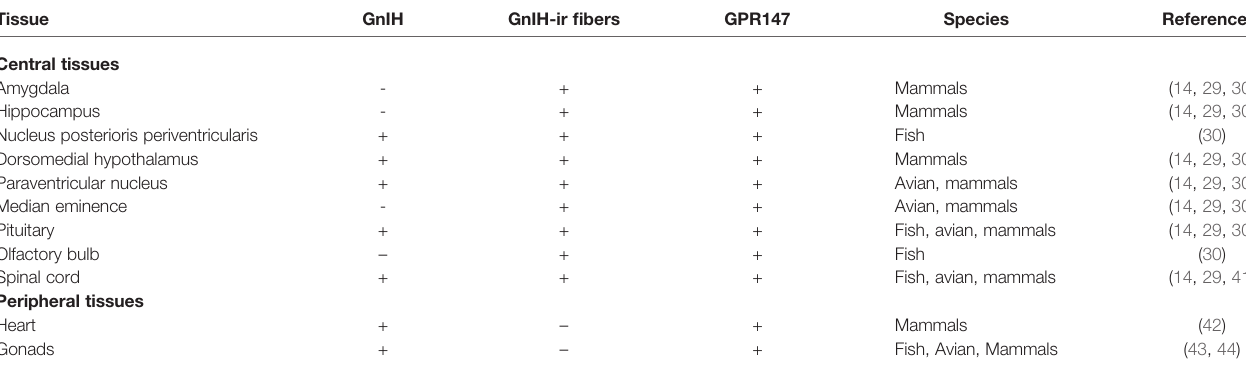
TABLE 1 | Distribution of GnIH, GnIH-ir fi bers, and GPR147 in various central and peripheral tissues. Tissue GnIH GnIH-ir fi